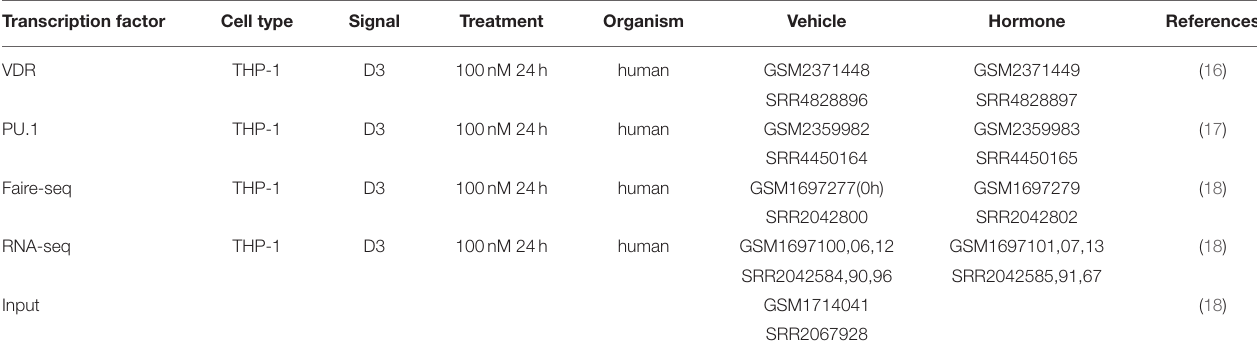
TABLE 1 | Control and 1,25(OH) 2 D 3 (D3)-stimulated ChIP-seq, FAIRE-seq, and RNA-seq data in THP-1 cells